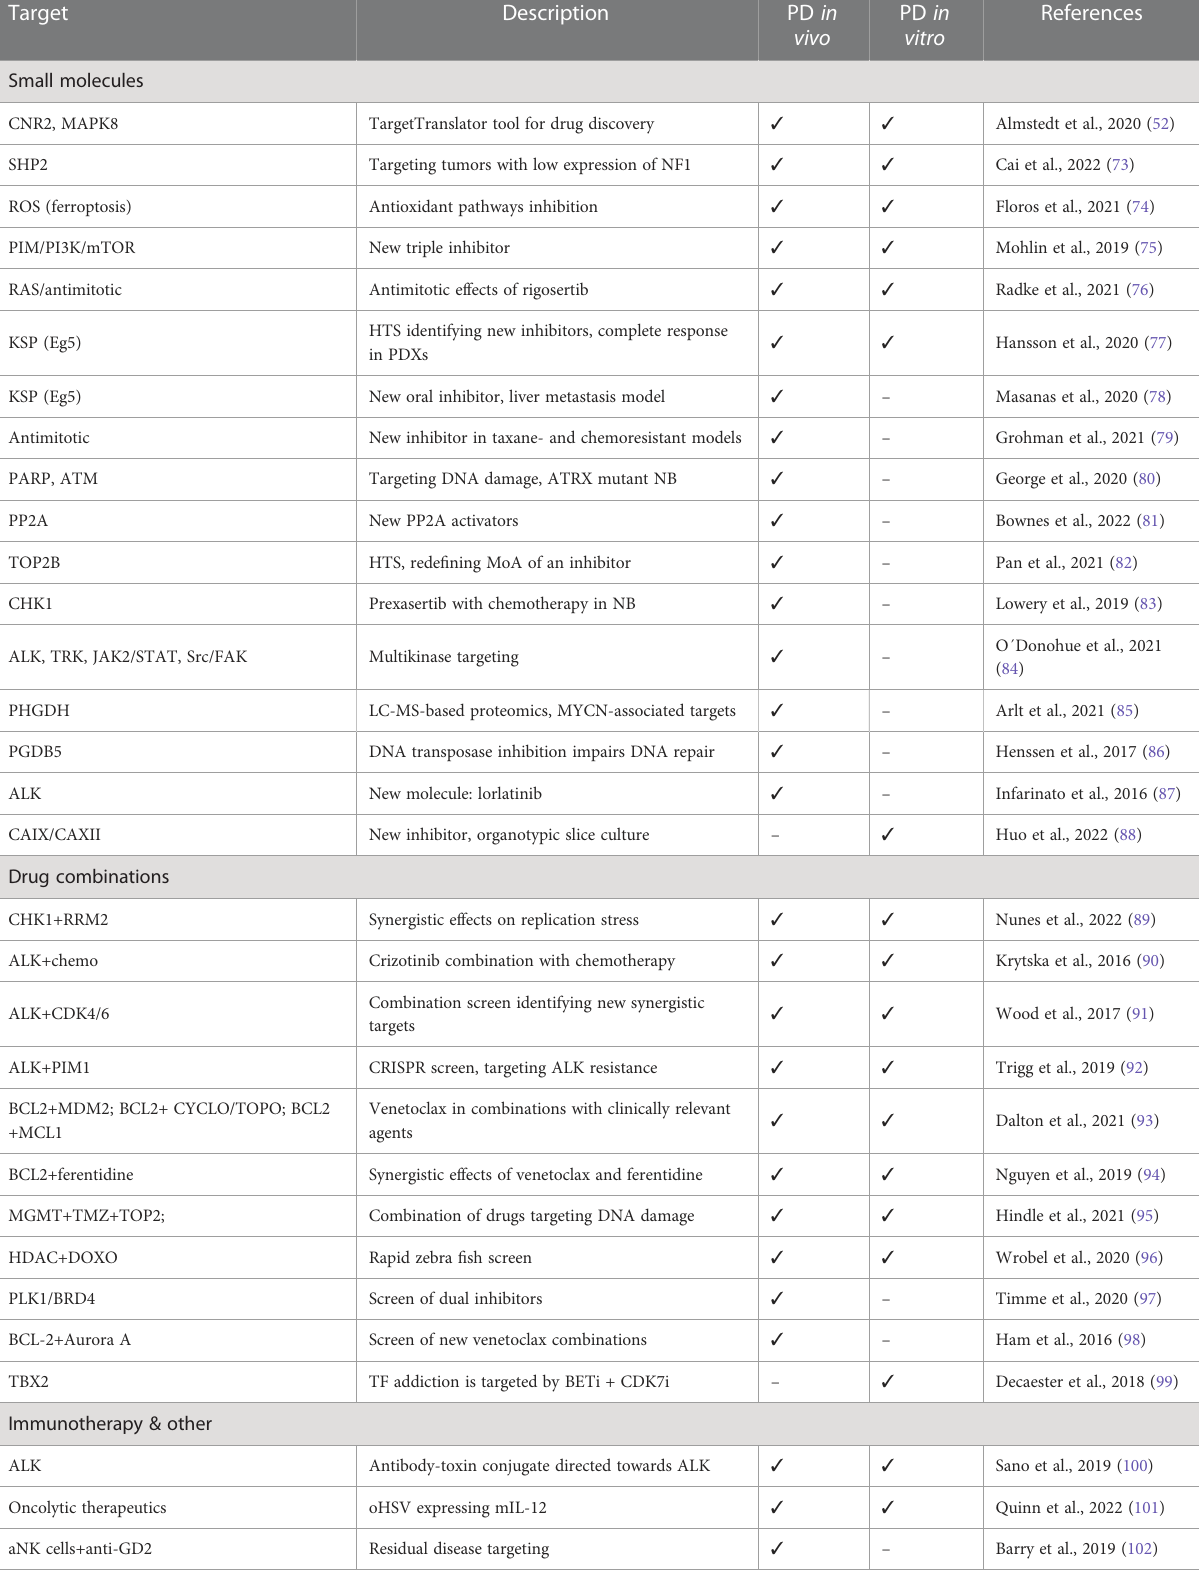
TABLE 1 Selected preclinical drug testing studies using NB patient-derived